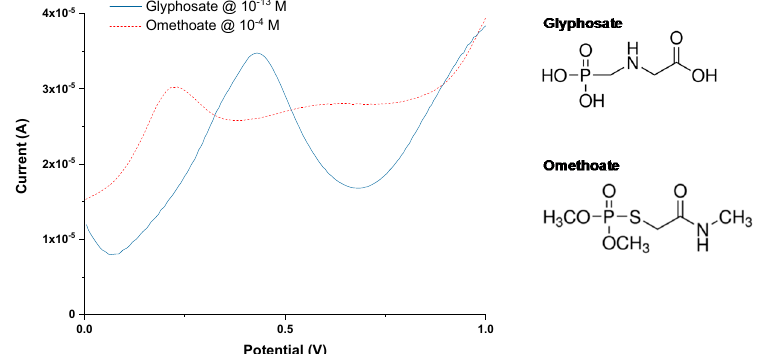
Figure 3. Current variation versus potential corresponding to glyphosate and omethoate detection by MIP based sensor ( left ); chemical structure of the two pesticides ( right